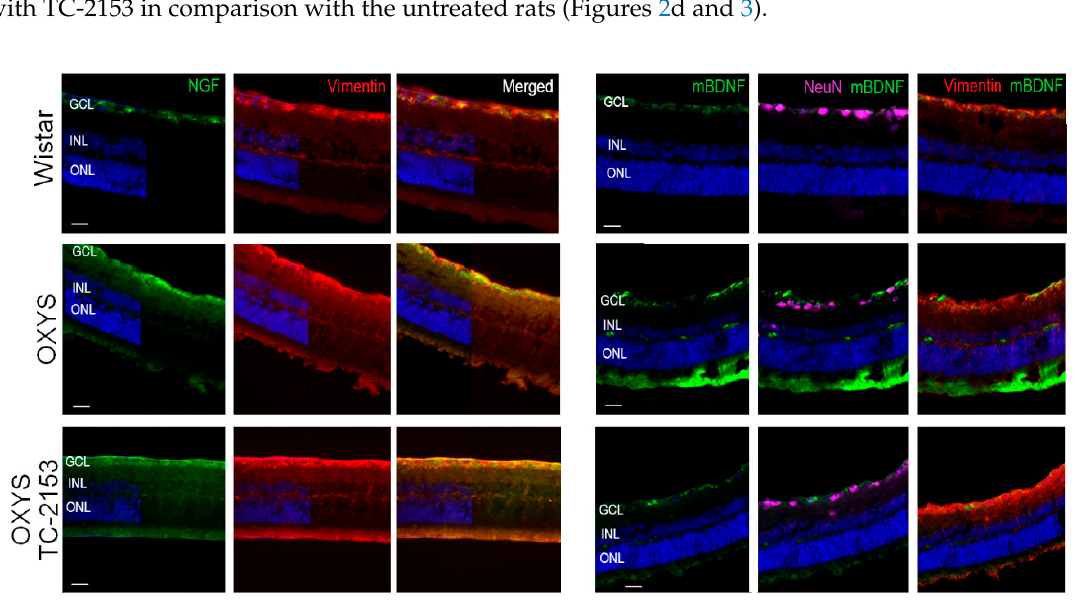
Figure 3. Effects of the STEP inhibitor (TC-2153) on mBDNF and NGF expression in 13-month-old OXYS rats. Representative images of a Wistar or OXYS retina stained with antibodies against NGF, mBDNF, NeuN, and vimentin. Cell nuclei were stained with DAPI. Scale bar = 20 µm. GCL, ganglion cell layer; INL, inner nuclear layer; and ONL, outer nuclear layer.